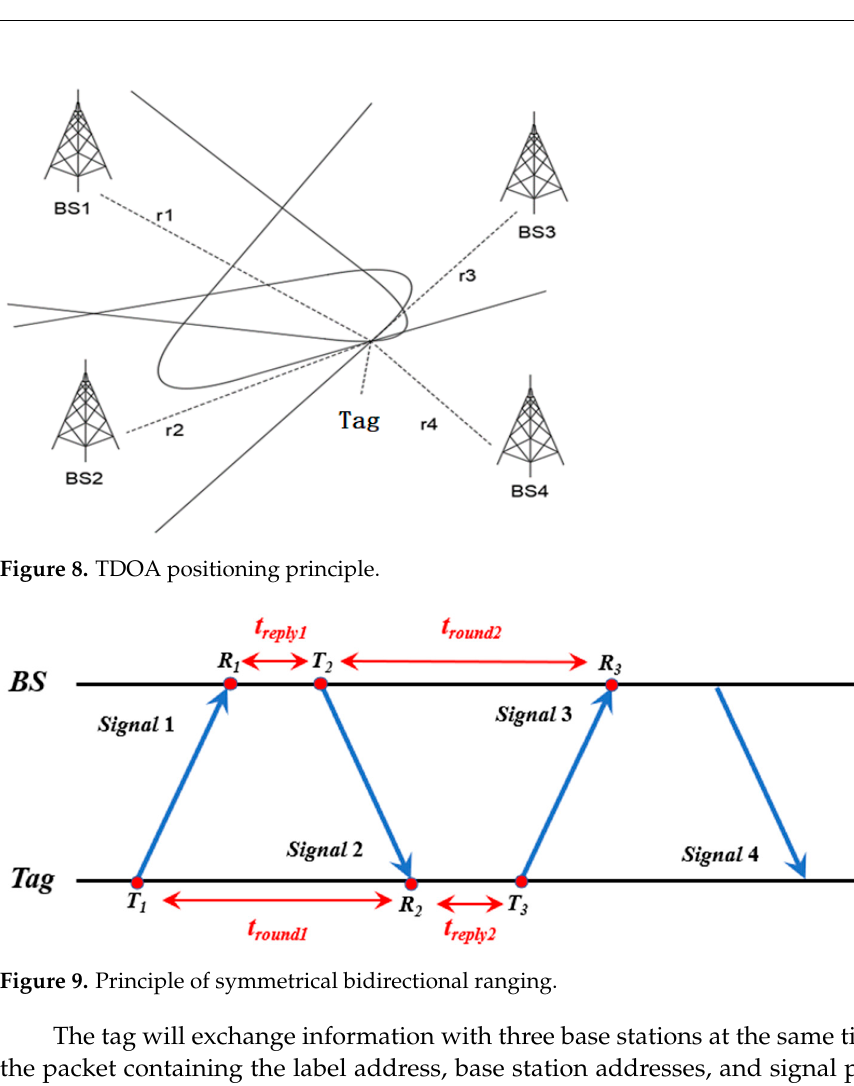
Figure 9. Principle of symmetrical bidirectional ranging.